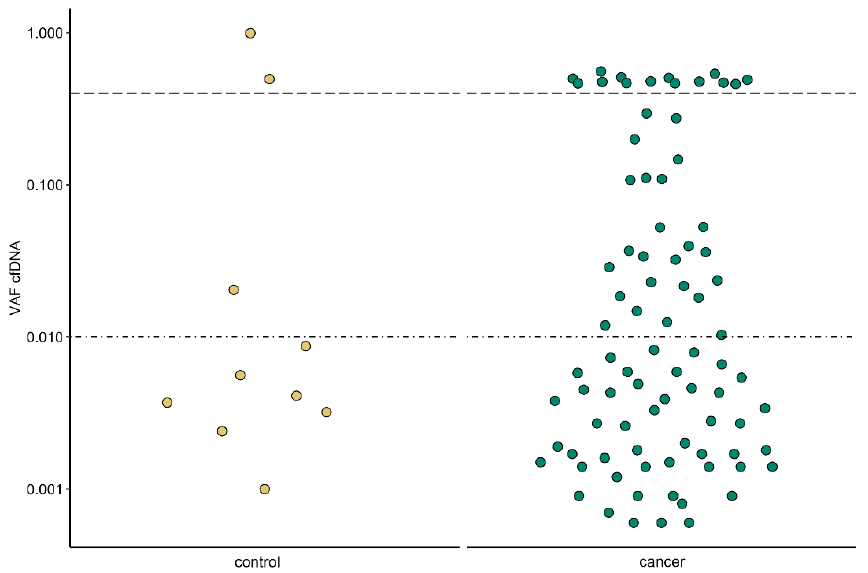
Figure 1. Cell-free DNA (cfDNA) variant allele fractions (AF) observed in control (left/yellow) and cancer patients (right/green) by using default filtering. The variant AF thresholds used for custom filtering are shown as horizontal lines at 1 % and 40 % variant AF.